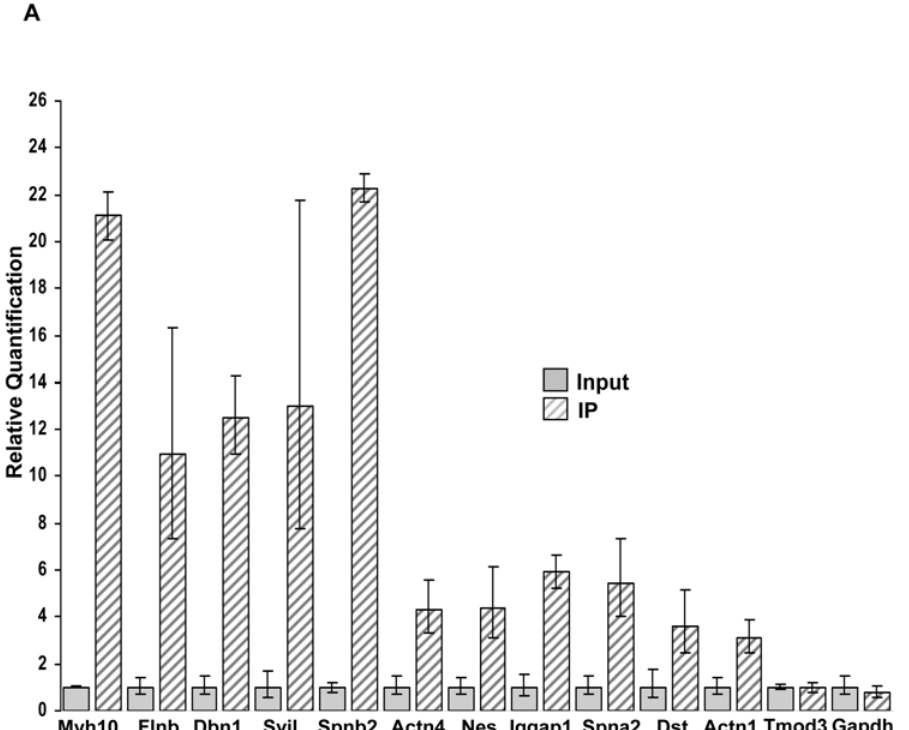
Figure 2. Enriched mRNAs identified by microarray analysis are independently validated by qRT-PCR. Quantitative RT-PCR analysis of a subset of the enriched mRNAs identified in this study. Two independent pulldowns using MPC-5 cell extracts stably WT1( + KTS)-FF-ZZ were completed and total RNAs from input extracts and WT1( + KTS) enriched fractions following TEV protease cleavage were compared. Mean expression values from triplicate assays 6 SD are shown relative to the input control